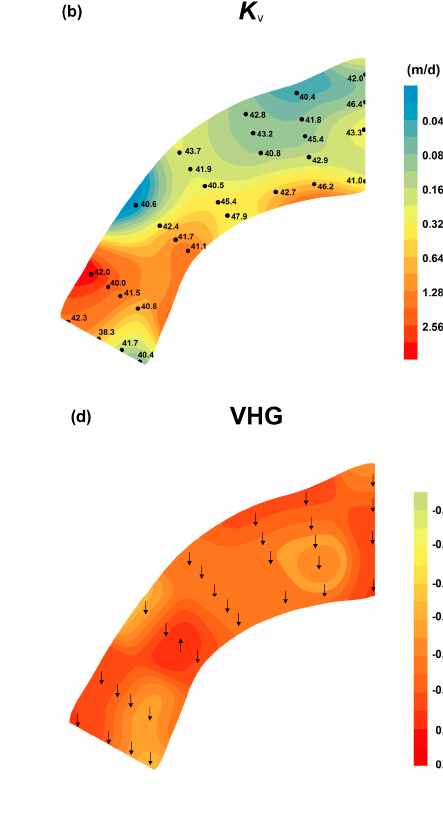
Figure 4. Interpolated contour plots of K v ( a , b ), VHG ( c , d ), and Darcian flux ( e , f ) in July 2015 (the left plots) and January 2016 (the right plots). (The length of sediments columns has been showed at each test point in plot ( a , b ); upward and downward arrows in plot ( c , d ) represent upwelling and downwelling, repectively). 3.2. Vertical Head Gradient The VHG describes the direction and intensity of the water exchange between the hyporheic zone and the surface or the subterranean zone [32] . The VHG varied between − 0.41 and 0.01 and − 0.25 and 0.04 in July 2015 and January 2016, respectively (Table 2). Most VHG values were negative, showing downwelling of stream water across the channel during the two test periods (Figure 4c,d). The results of data analysis indicated that high downward VHG values occurred in the upstream part of the channel, with much higher values adjacent to the apex of the bend in July 2015 (Figure 4c). During both test periods, the low downward gradients were in the center of the channel. However, the highest downward gradients occurred near the right bank in July 2015, whereas they occurred near the left bank in January 2016 (Figure 3c,d). In July 2015, the maximum value (0.41) of downward gradient corresponded to a 16 cm hydraulic head difference between the stream stage and the water level inside the pipe. The VHG showed a greater spatial variability in July 2015 than January 2016 across the study site (Table 2). There was a slight increase in median value of VHG values from July 2015 to January 2016, whereas a higher average VHG value was observed in July 2015. The magnitude of VHG showed an increasing trend after the initial decrease in July 2015, but fluctuated up and down around the average value along the channel (Figure 5). The Kruskal-Wallis test was used to verify whether VHG showed significant differences across the channel or between the two test periods.